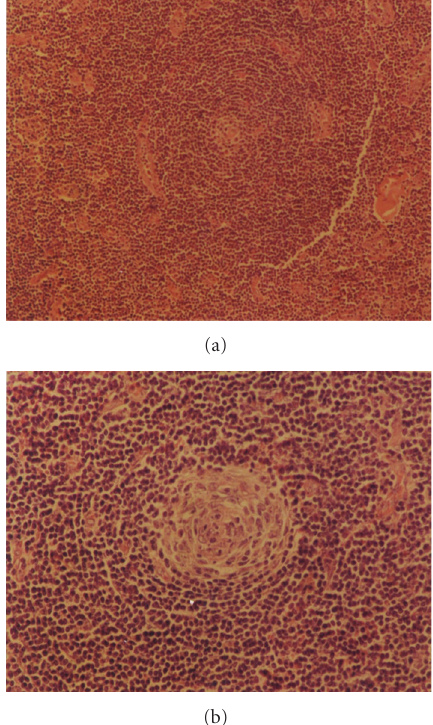
Figure 3: Lymph node shows large nodules of mantle cells arranged concentrically around atrophic and vascularized germinal centers, hematoxylin, and eosin, × 100 and × 400.